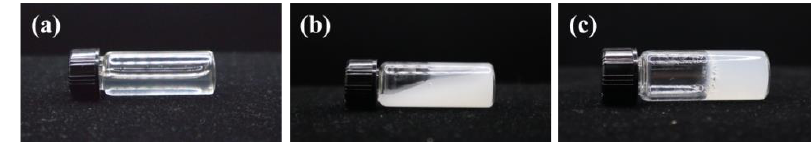
Figure 5. Dynamic time sweep analysis of various CMG hybrid hydrogels.